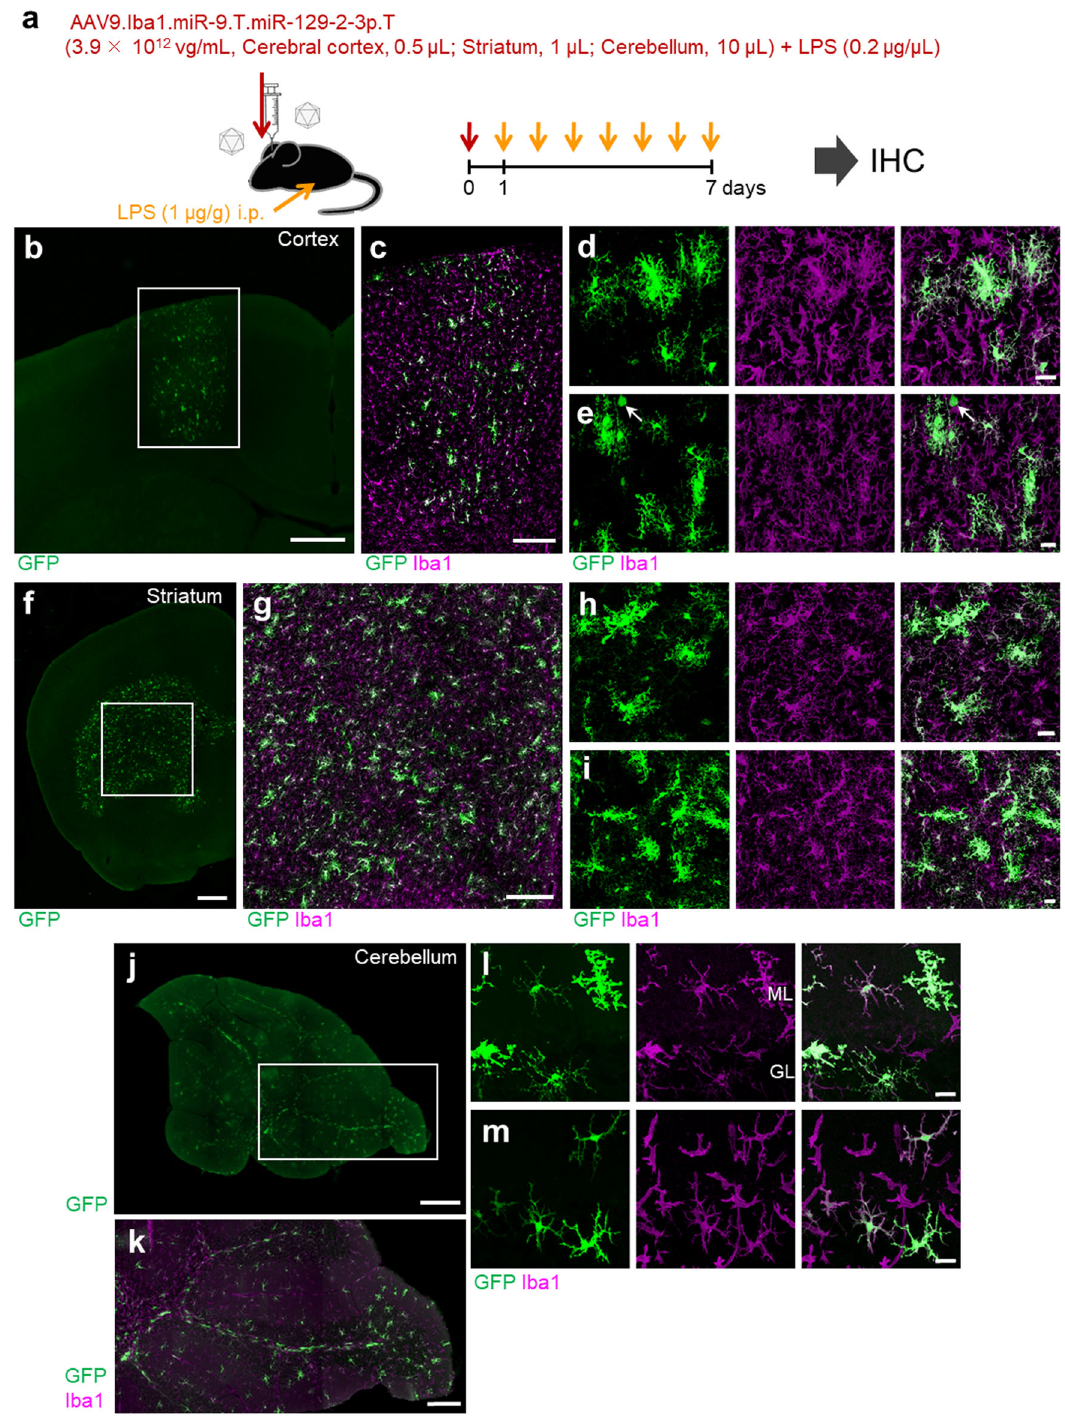
Fig. 4 Robust transduction of microglia in LPS-treated mice. a Diagram depicting the experimental protocol. A solution containing AAV9.Iba1.miR- 9.T.miR-129-2-3p.T and LPS (0.2 μ g/ μ L) was injected into the three brain regions at Day 0, followed by supplemental intraperitoneal injection of LPS (1 μ g/g body weight) daily up to Day 7. Mice were killed 6 h after the LPS injection on Day 7. Brain slices were immunolabeled for GFP and Iba1. b – m Low, middle, and high magni fi cation of the cerebral cortex ( b – e ), striatum ( f – i ), and cerebellum ( j – m ). Square regions in ( b ), ( f ), and ( j ) were enlarged to ( c ), ( g ), and ( k ), respectively. Scale bars: 500 μ m ( b , f , j ), 200 μ m ( c , g , k ), and 20 μ m ( d , e , h , i , l , m ). GL granule cell layer, LPS lipopolysaccharide, ML molecular layer. Next, we examined whether our microglia-selective gene expression method could be used to measure Ca 2 + signal from a genetically encoded fl uorescent calcium indicator, G-CaMP7.09 43 . At least one week after AAV injection (AAV9-Iba1-G-CaMP7.09- miR-9.T-miR-129-2-3p.T; 3.9 × 10 10 vg/mouse) to the cerebellum, COMMUNICATIONS BIOLOGY| (2022) 5:1224